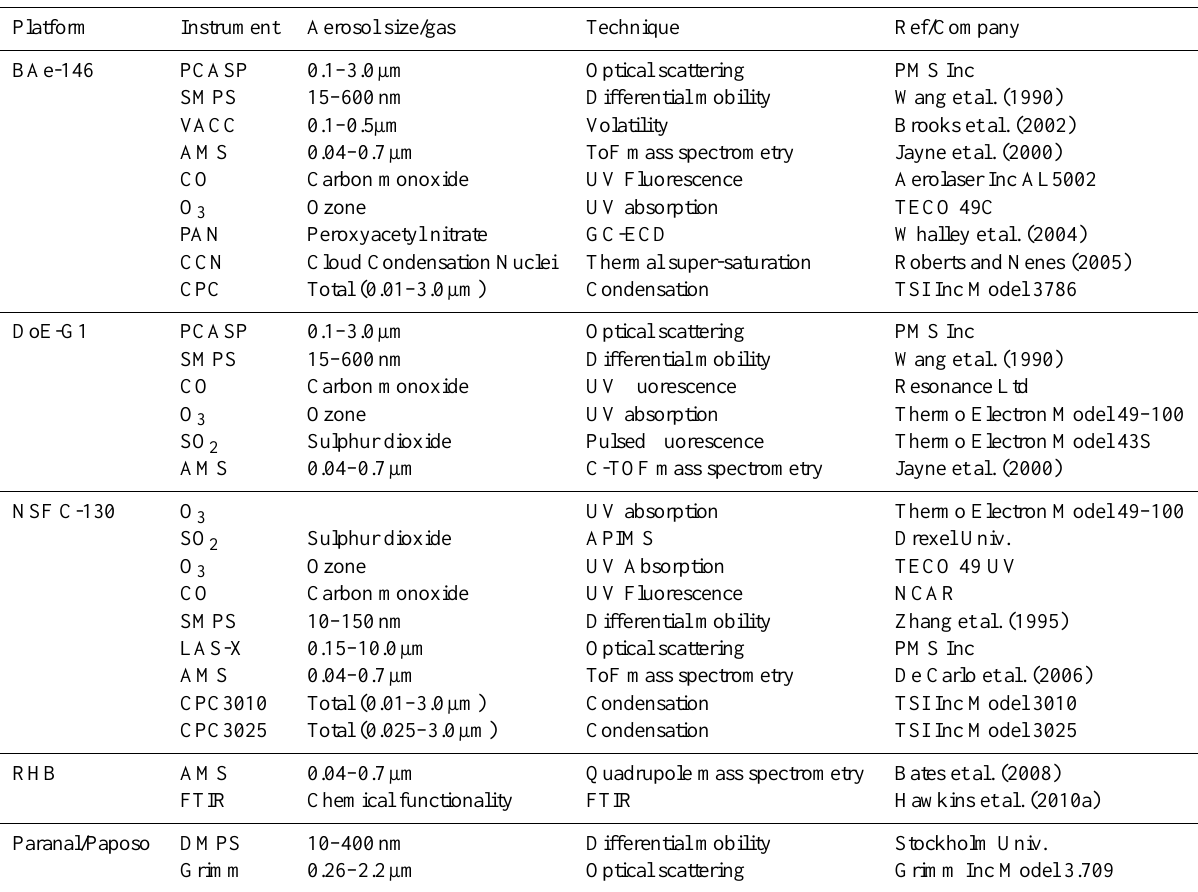
Table 2. Selected aerosol and trace gas instruments onboard the various platforms considered in this study. Measured particle size ranges (as sampled particle diameter) are stated where